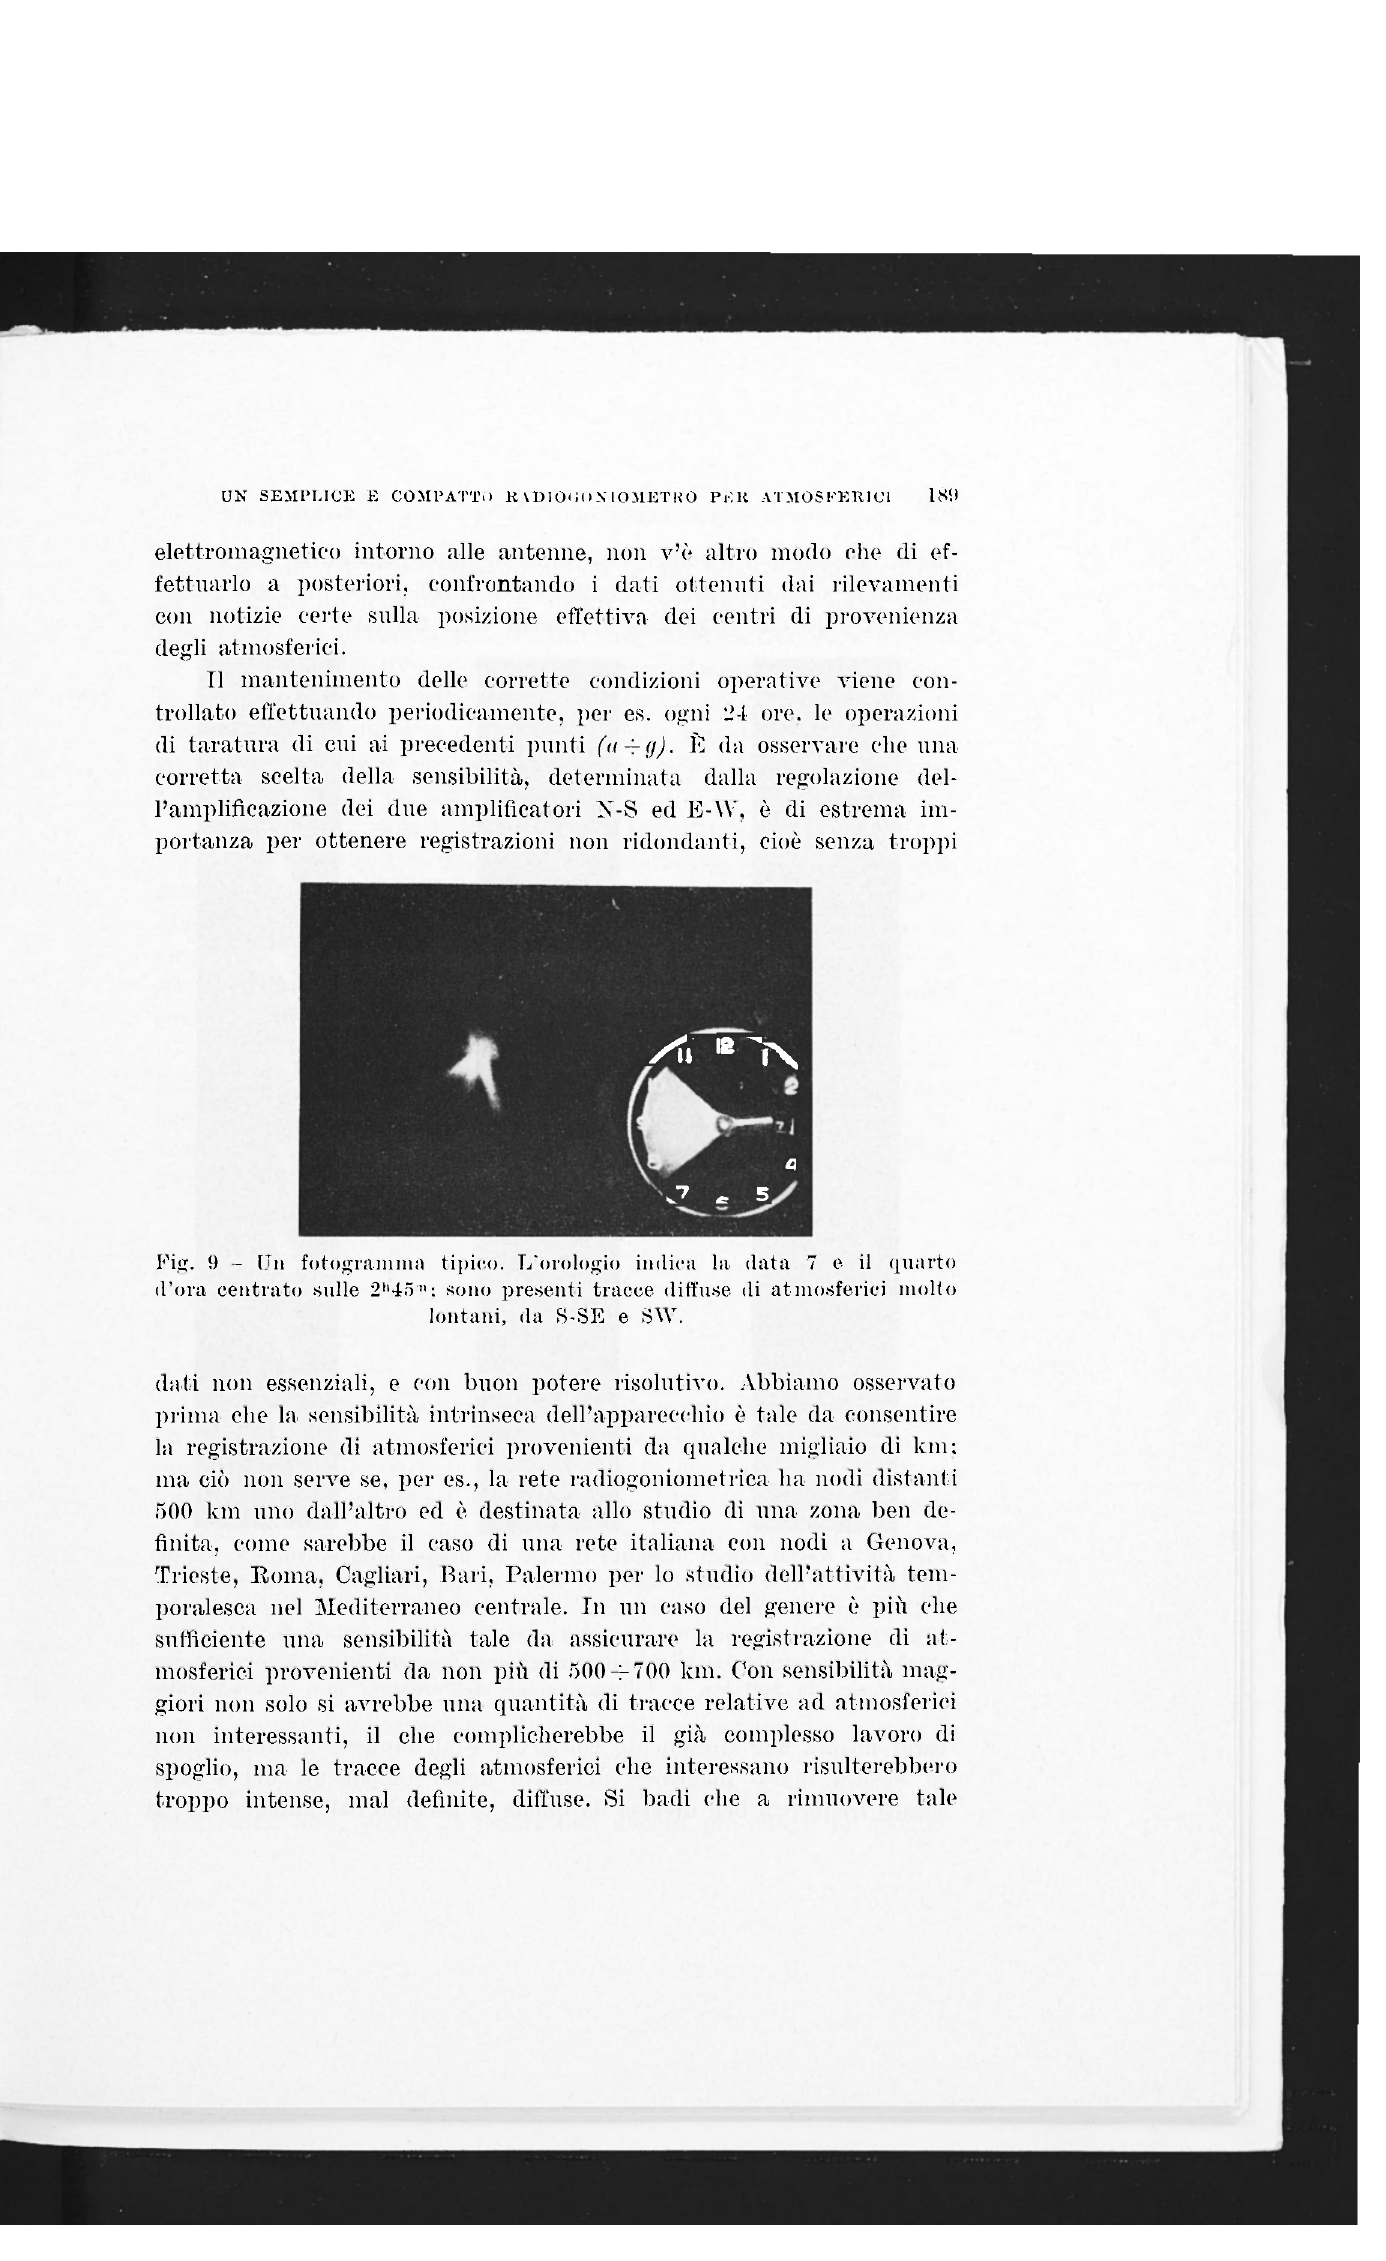
Fig. 9 - Un fotogramma tipico. L'orologio indica la data 7 e il quarto d'ora centrato sulle 2 h 45 11 ; sono presenti tracce diffuse di atmosferici molto lontani, da S-SE e